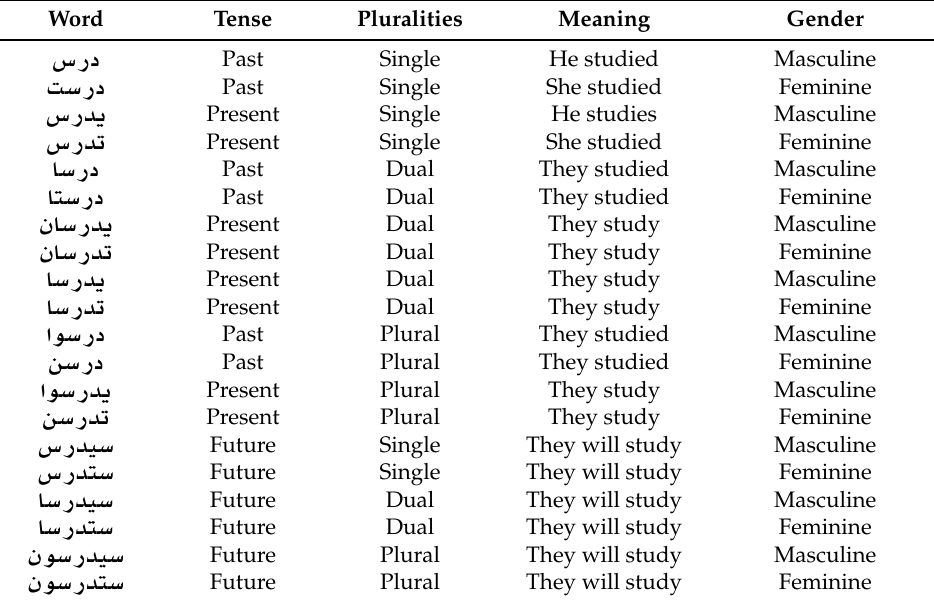
Table 3. Different morphological forms of word study ( xC ).